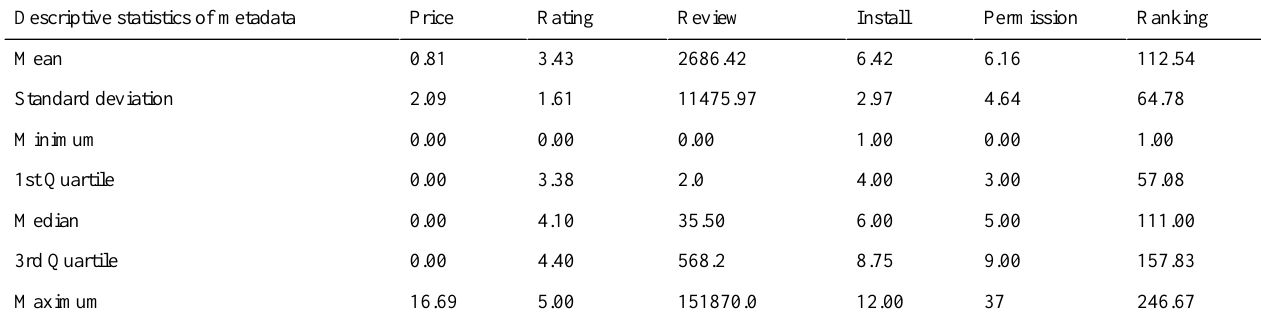
Table 2. Descriptive statistics of anxiety apps on Google Play. RankingPermissionInstallReviewRatingPriceDescriptive statistics of